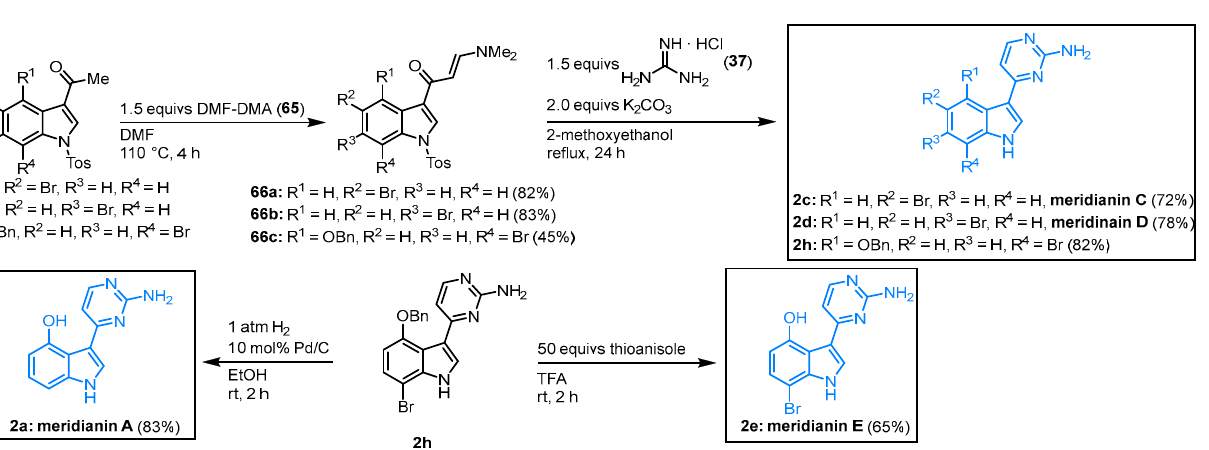
Figure 13. First synthesis of meridianins D and G [53].